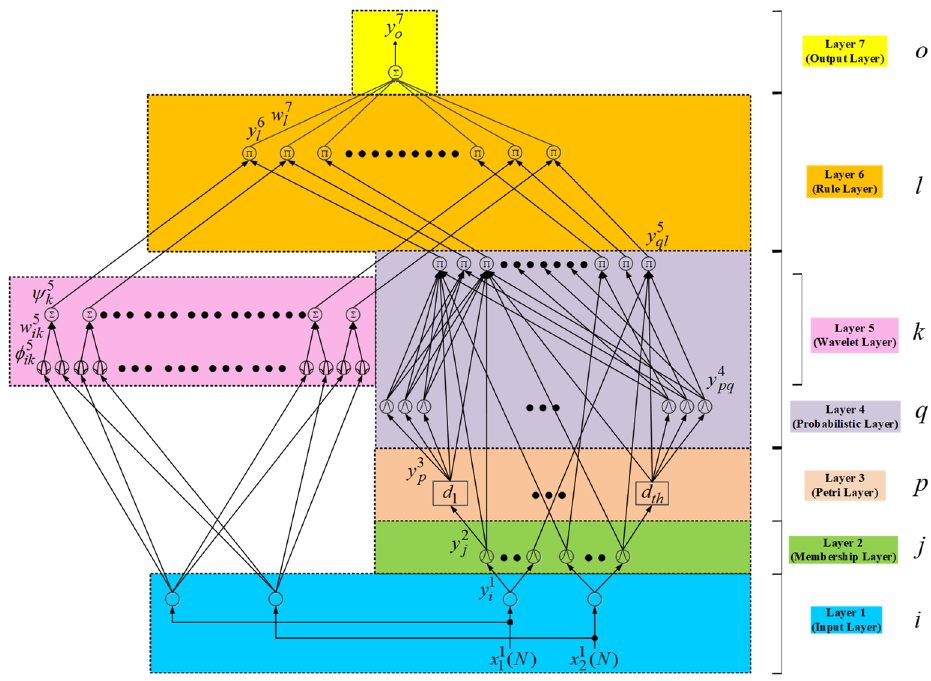
Figure 3. Network structure of proposed PPWFNN controller.